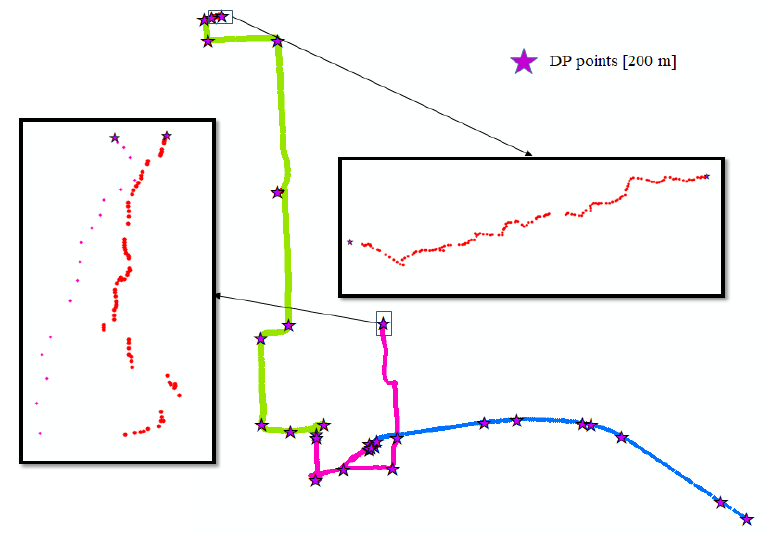
Figure 9 . DP trajectory compression with a threshold of 200 m